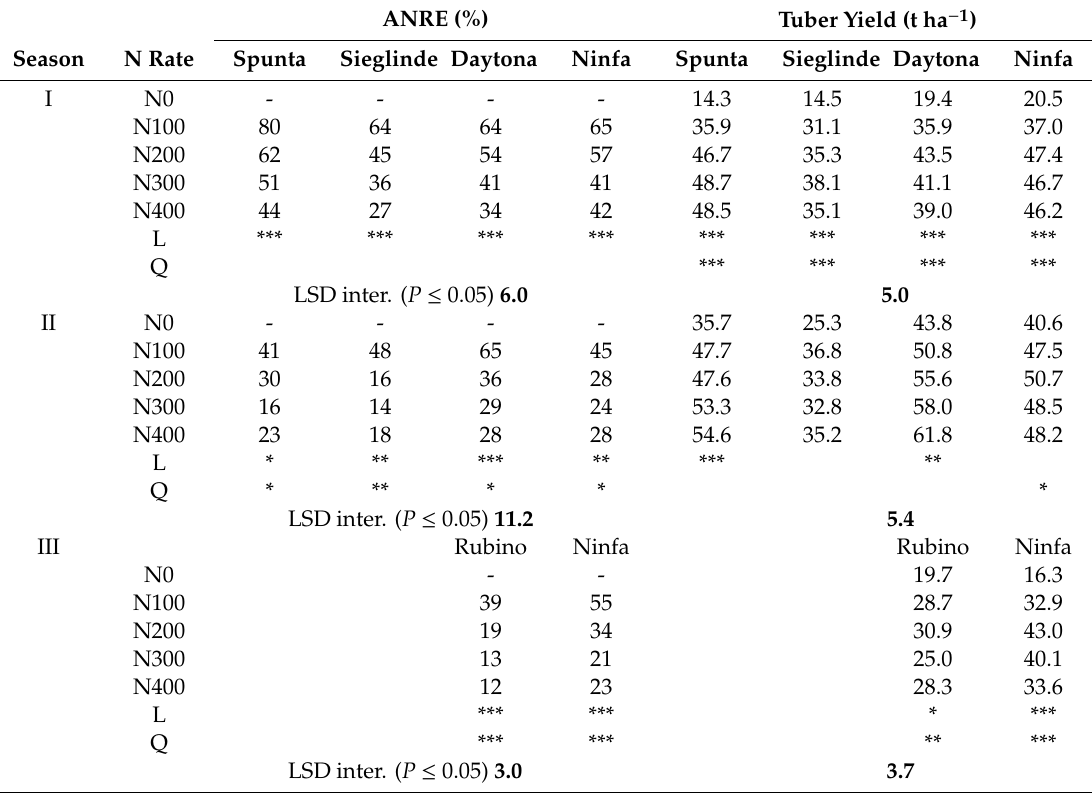
Table 3. Apparent nitrogen recovery e ffi ciency (ANRE) and tuber yield as a ff ected by “nitrogen rate x cultivar” interaction in the three seasons. Relationship tested by regression analysis, between N rate and responses of each variable and cultivar (L = linear, Q = quadratic; *, **, *** indicate significance at P ≤ 0.05; P ≤ 0.01; P ≤